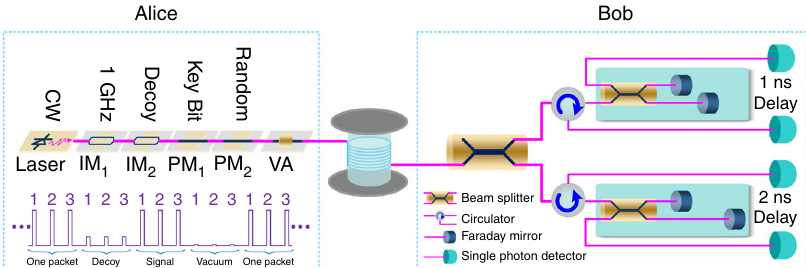
Fig. 4 Experimental setup to implement the RRDPS protocol with L = 3. CW Continuous Wave, IM Intensity Modulator, PM Phase Modulator, VA Variable Attenuator. At Alice ’ s site, a pulse train with a repetition rate of 1 GHz is generated by modulating a 1550.12 nm CW laser using IM 1 . Every 3 pulses ( L = 3) are de fi ned as one packet. The intensity of each packet is randomly modulated by IM 2 to prepare signal, decoy and vacuum states. PM 1 adds phase − π /2 or π /2 on each pulse to encode the key bits, and PM 2 adds a random global phase on each packet. The VA is used to adjust the average photon-number per pulse. At Bob ’ s site, through a 1 × 2 beam-splitter, the incoming signal is randomly coupled into one of two unbalanced Faraday – Michelson interferometers (FMIs) with 1 and 2 ns temporal delays. Each output of the FMIs is led to an SPD. Finally, the detection events are recorded to extract key